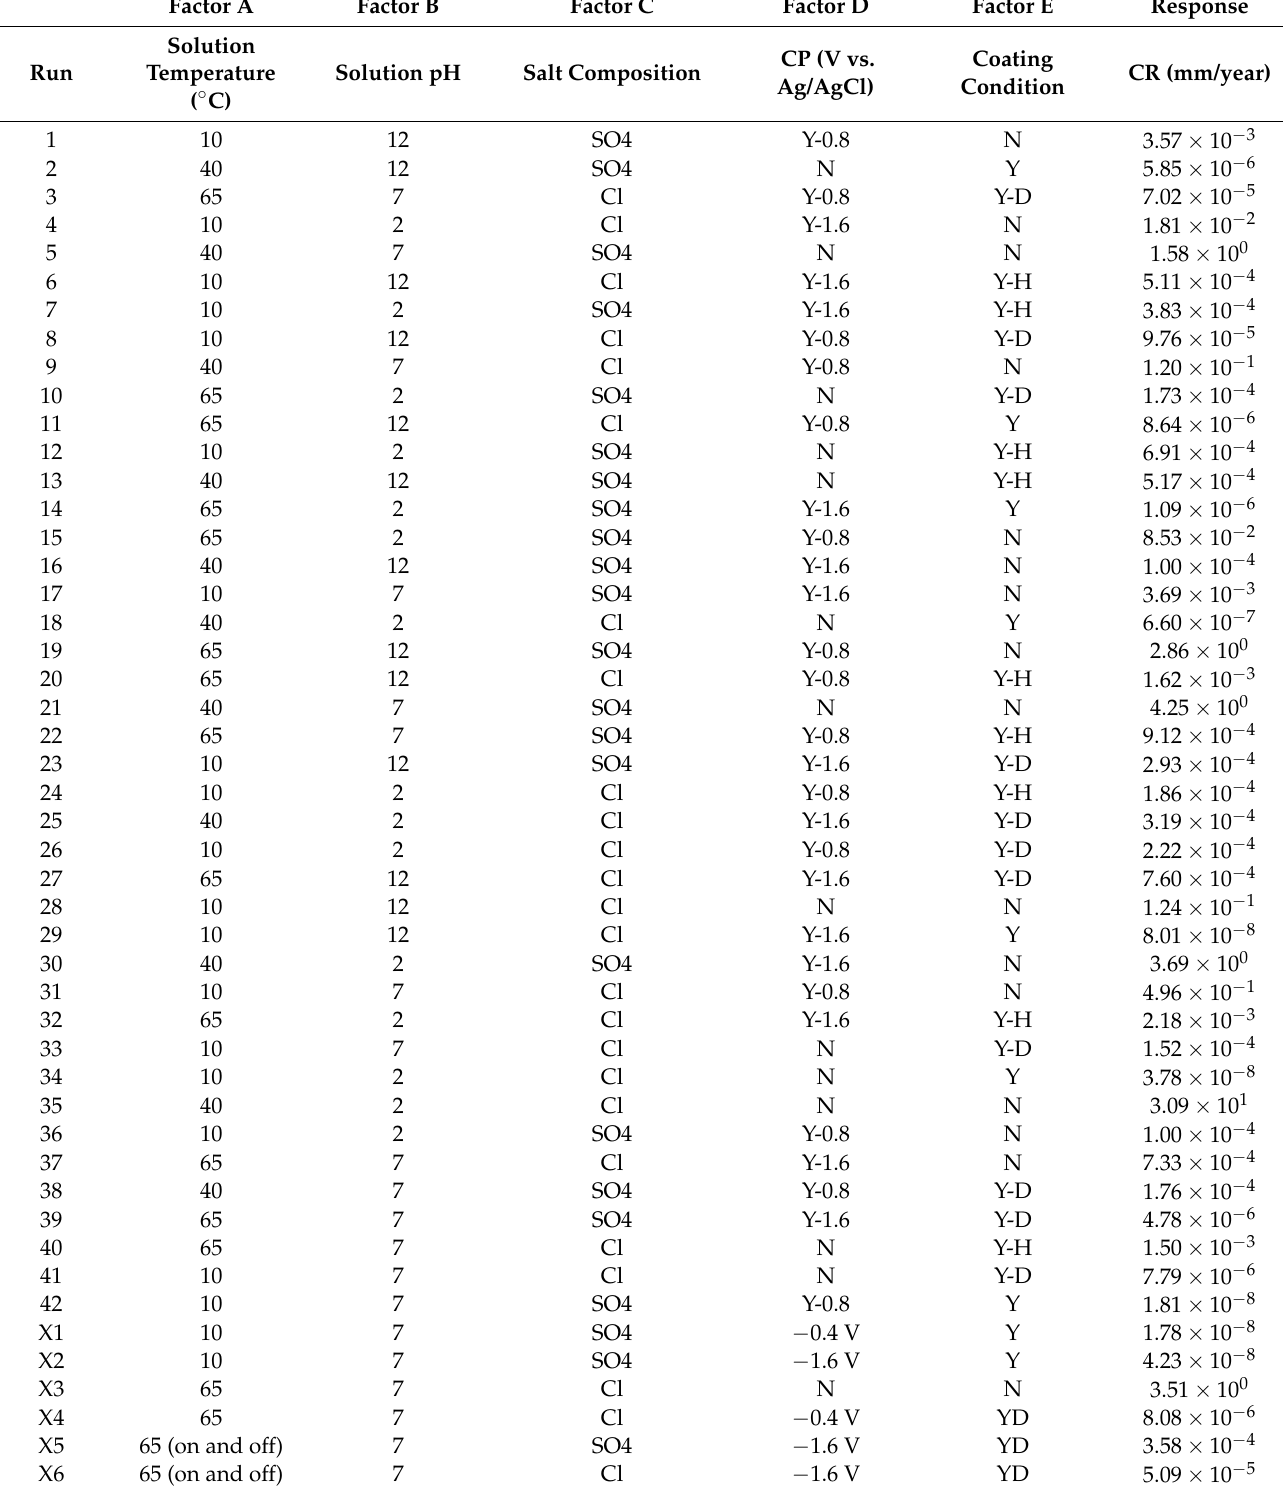
Table 3. Levels and description of variables in actual